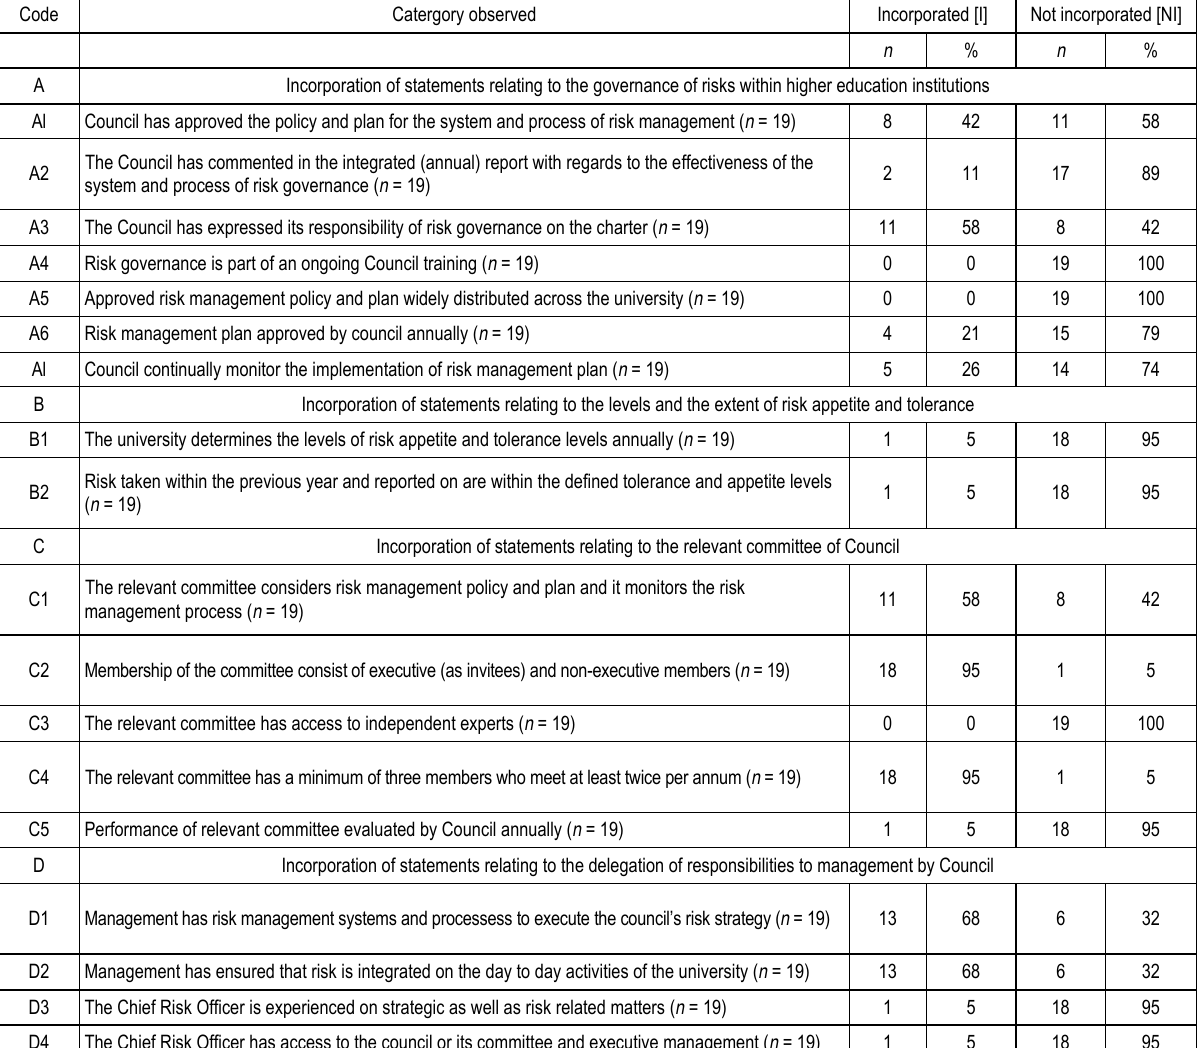
Table 2. Governance of risk, tolerance & appetite, relevant committee and delegation of responsibilities